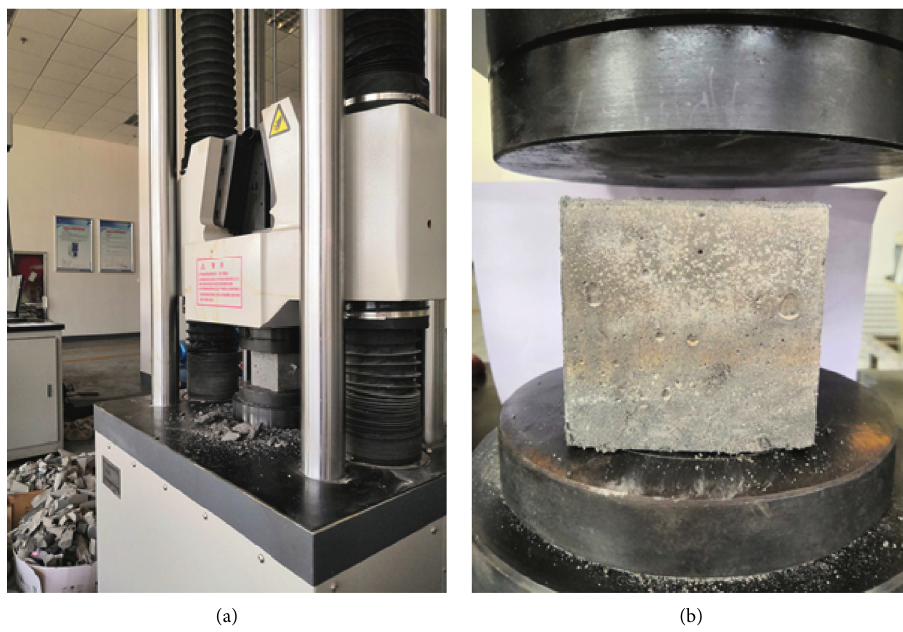
Figure 1: The unconfined compressive strength test.